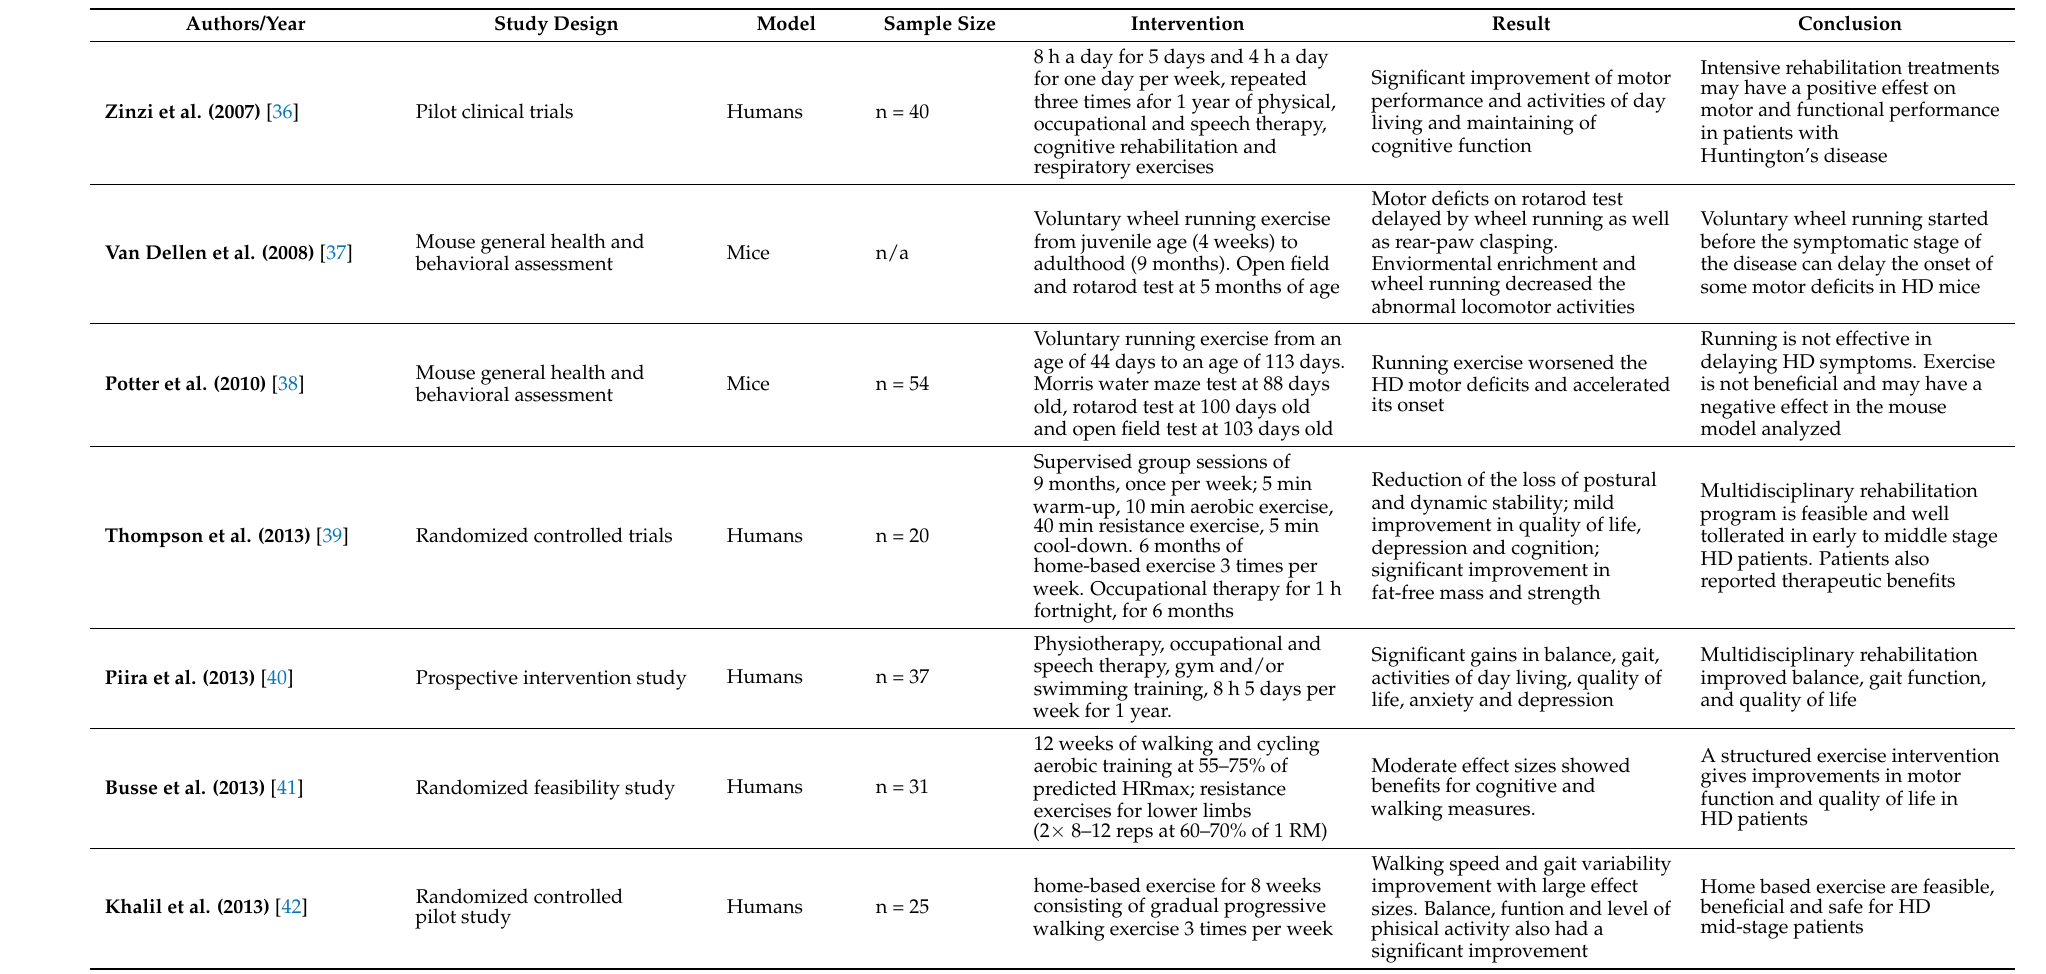
Table 1. Characteristics of included